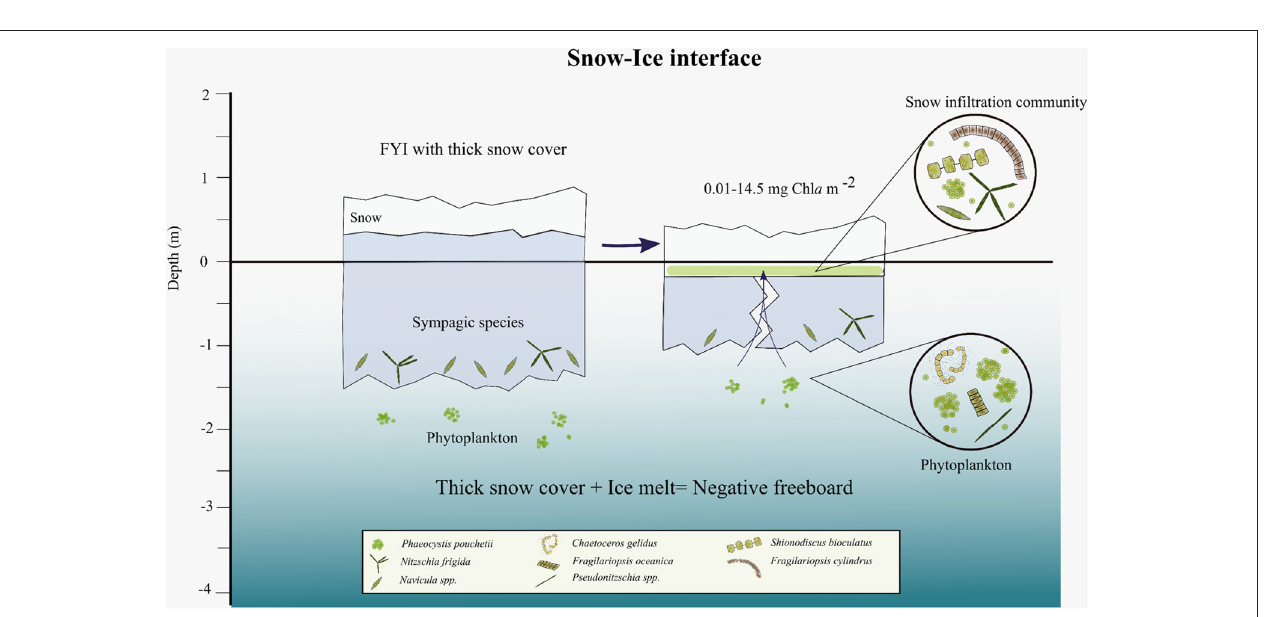
of the unconsolidated part (rubble), we added up the lengths of all the voids inside the rubble ice and divided by the total lengths of all the drill holes inside the rubble. Six videos of the underwater part of the ridge were recorded with a GoPro Hero black on 25